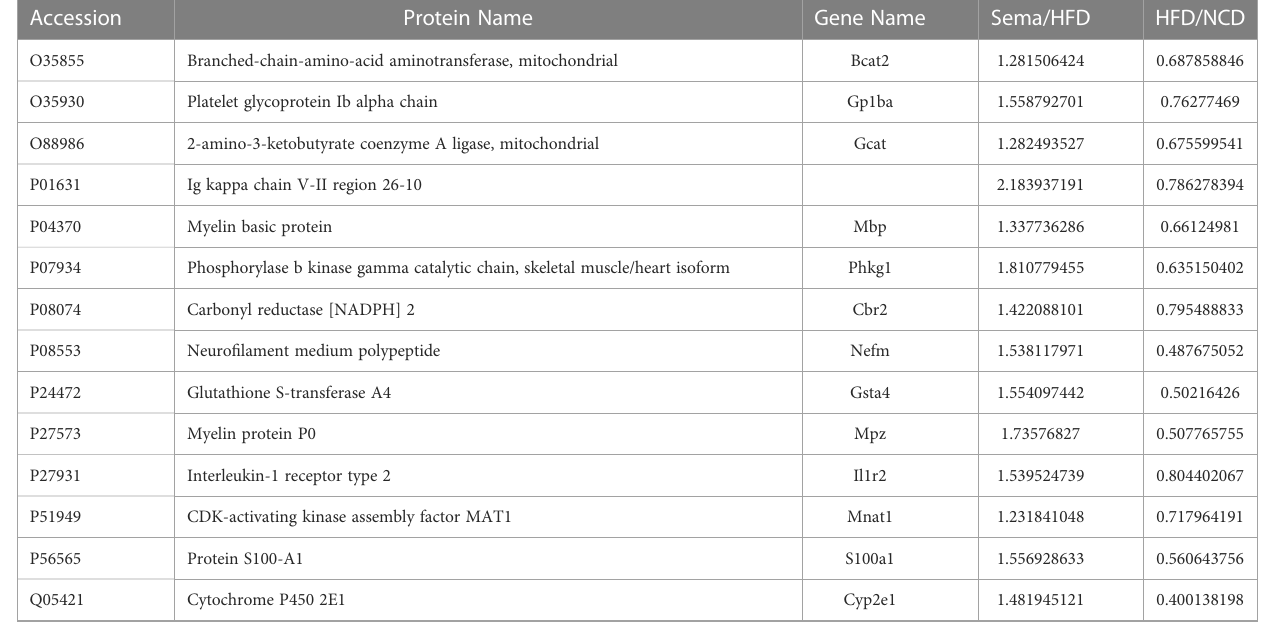
TABLE 2 List of the DEPs reversed by semaglutide between HFD/NCD and Sema/HFD.